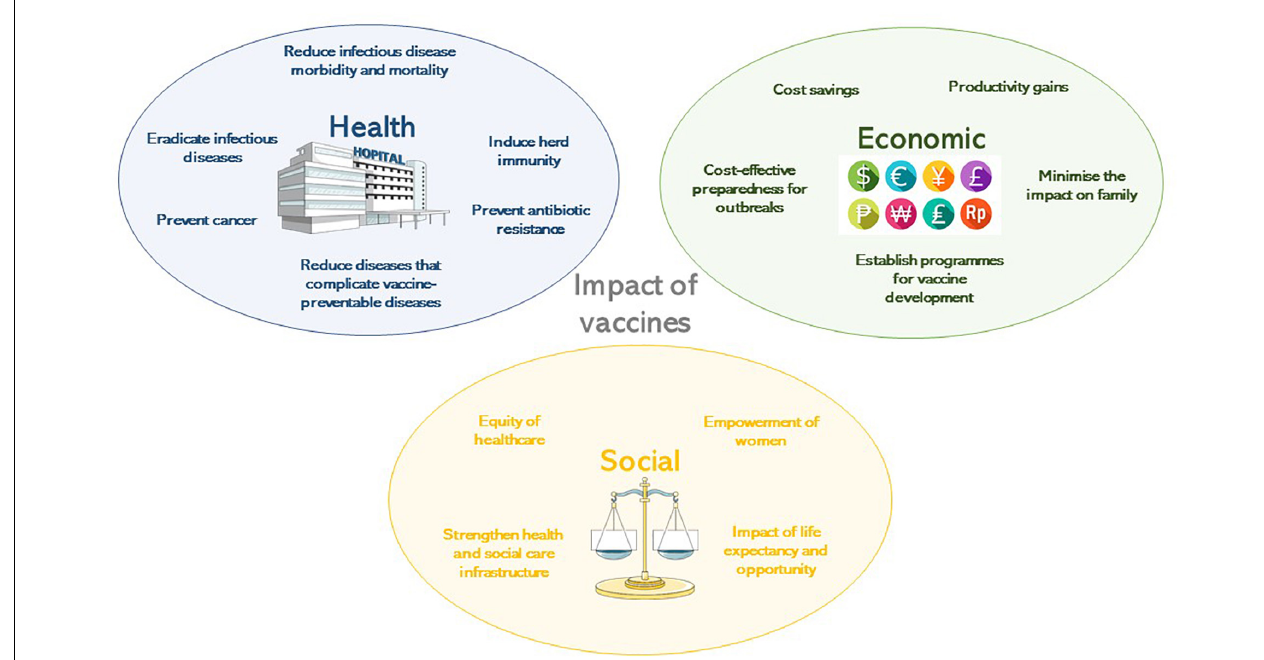
FIGURE 1 | The impact of vaccines according to their health, economic or social